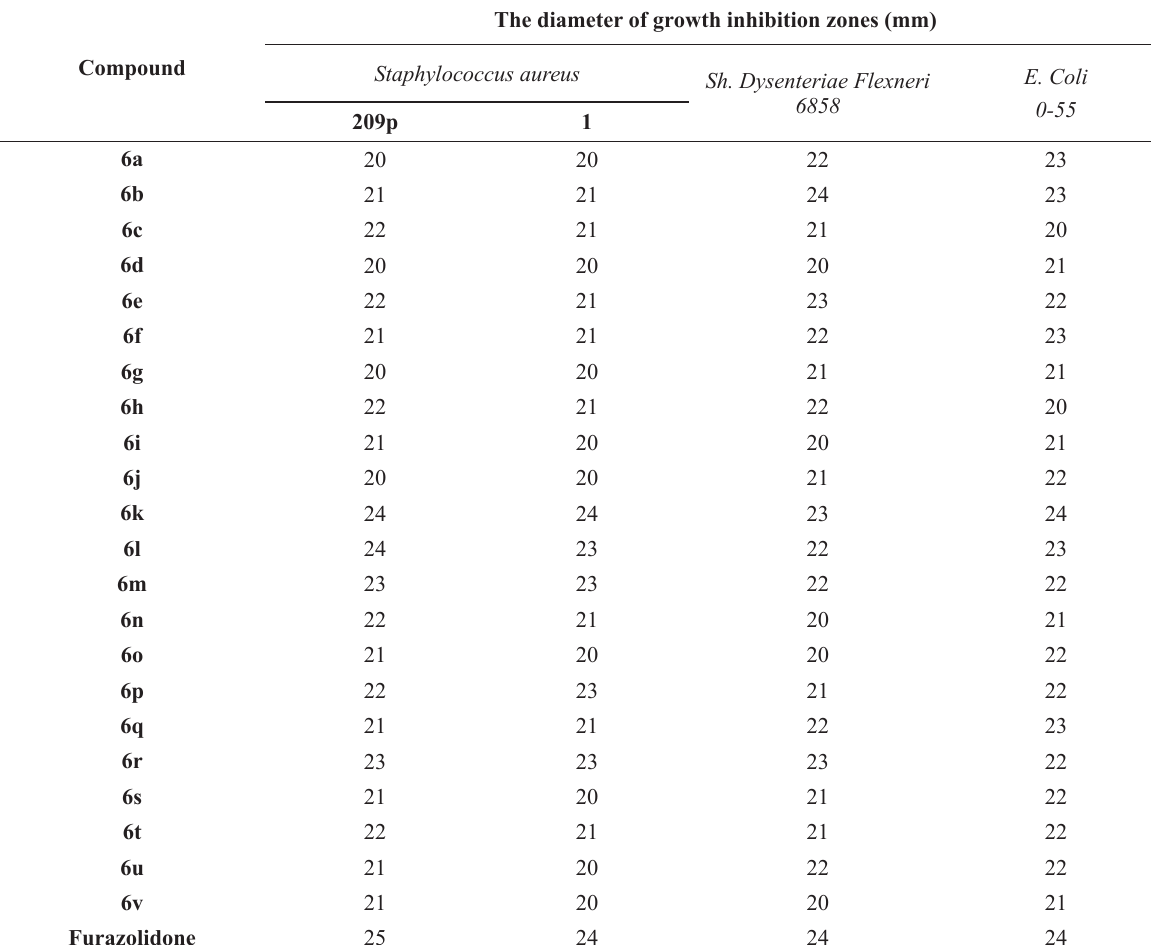
Antimicrobial activity of 8-amino derivatives of thieno[3,2-d]pyrimidine 6a‒v. The diameter of growth inhibition zones Compound